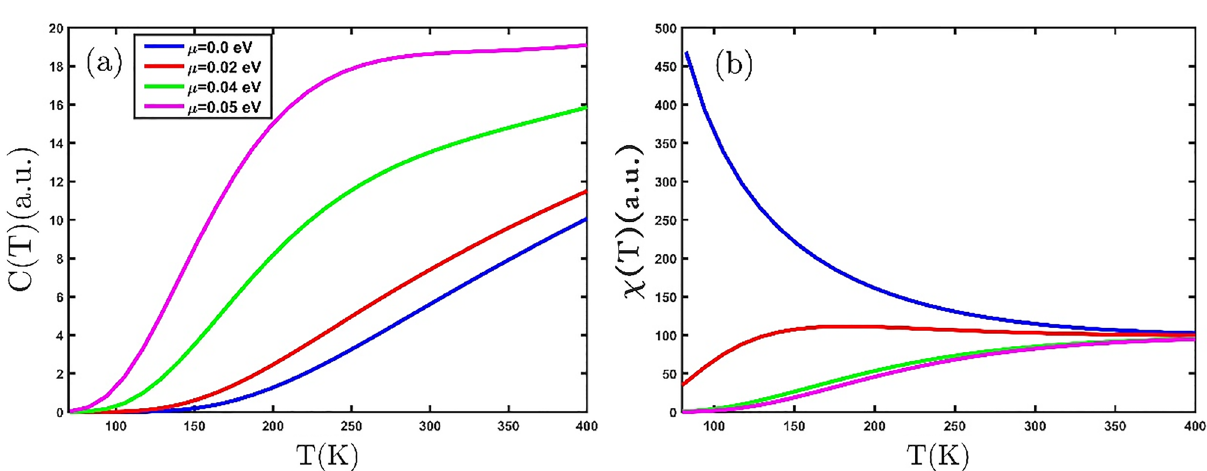
Figure 4. ( a ) The electronic heat capacity ( b ) magnetic susceptibility of the GeCH 3 SL versus temperature for various electron